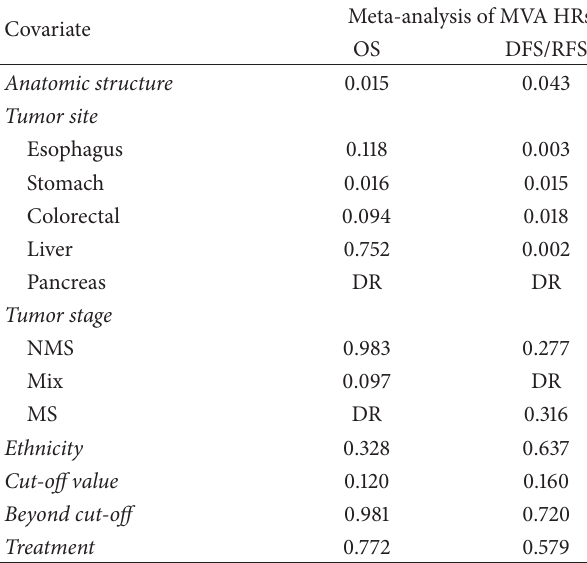
Table 4: 𝑃 values of